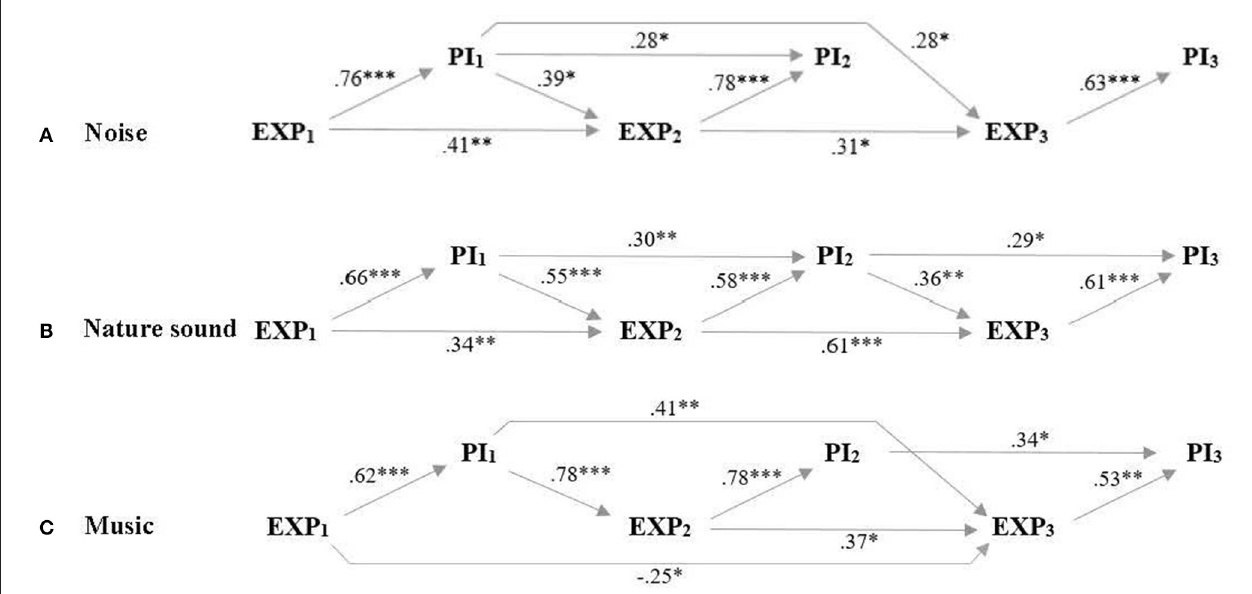
FIGURE 4 | Perceived and expected pain intensity. Path regression analysis of expectancy ratings on the 3 test days (EXP1, EXP2, EXP3) and perceived pain intensity on the 3 test days (PI1, PI2, PI3) as predictors for later expectancy and pain ratings when participants listened to (A) noise, (B) nature sound, and (C) music. Arrows and beta-values mark significant predictions and demonstrate that expected pain intensity predicted perceived pain intensity on all respective test days when including all previous expectancy and pain intensity ratings in the regression model. * p < 0.05; ** p < 0.01; *** p <